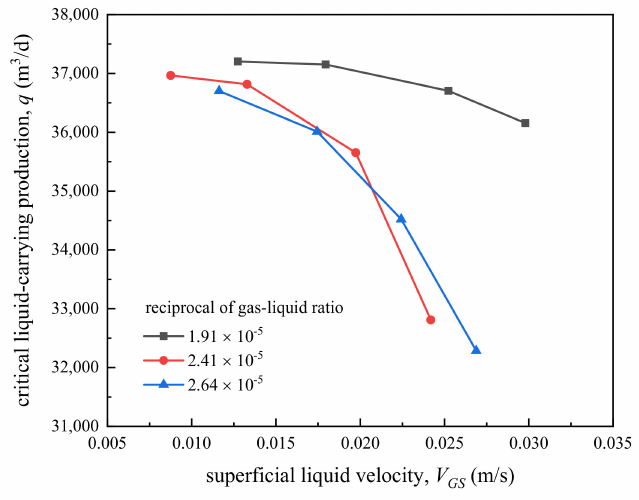
Figure 6. The relationship between superficial liquid velocity and critical liquid-carrying